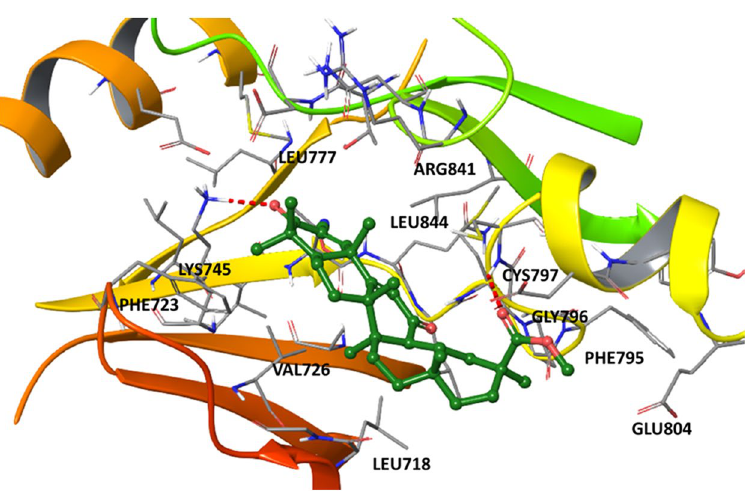
Figure 5. The docking complex of SM and EGFR (PDB ID: 1M17). SM is rendered as a stick and ball representation. Only residues situated less than 4 Å from the ligand has been shown. Hydrogen bonds between EGFR and SM are labeled as